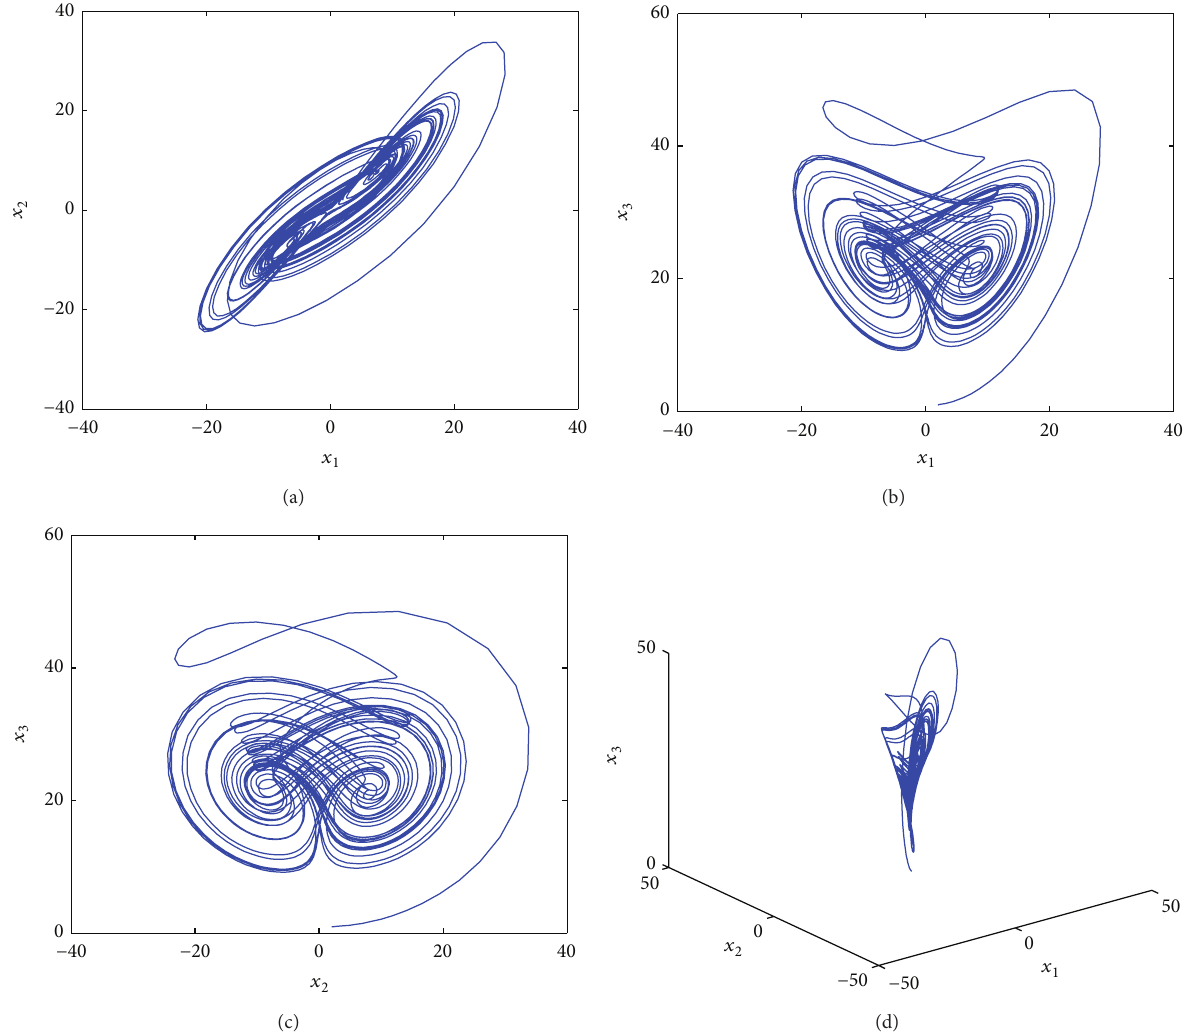
Figure 1: Chaotic attractors in the fractional order Chen system with 𝛼 = 0.95 . The panels (a), (b), (c), and (d) show the 𝑥 2 − 𝑥 1 , 𝑥 3 − 𝑥 1 , − 𝑥 𝑥 3 2 , and 3D views,